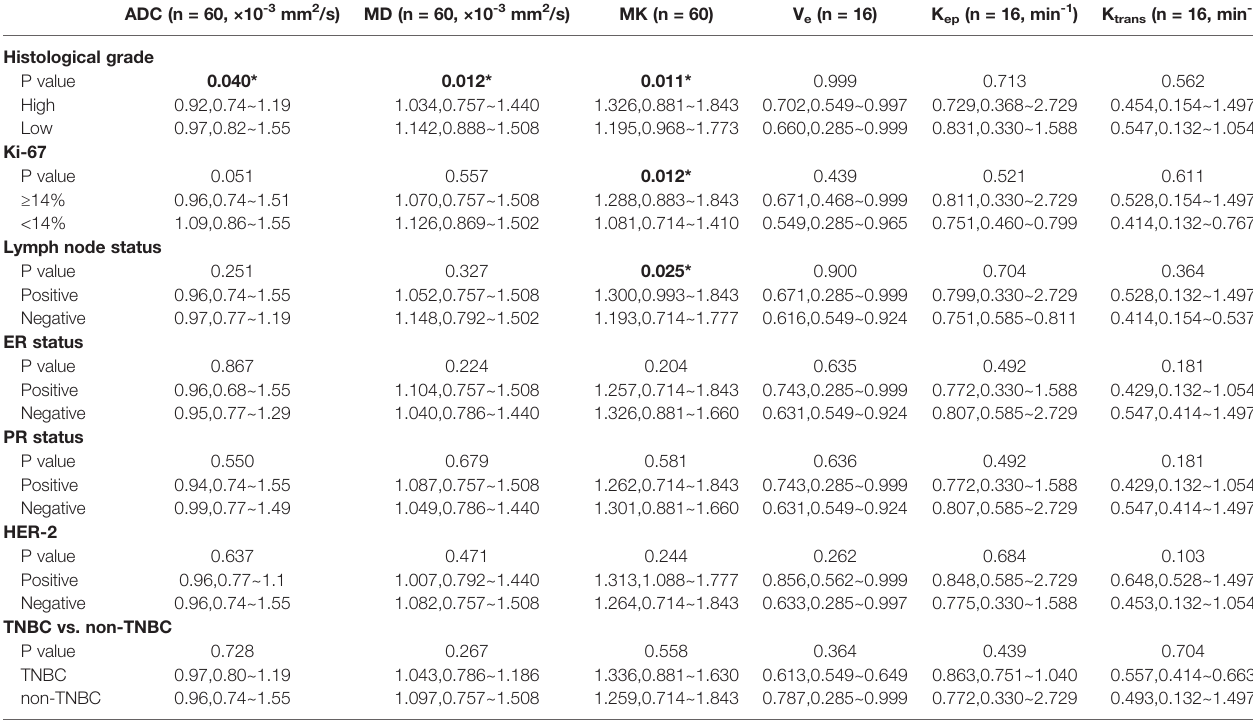
The bold values and the symbol * are all for marking the Signi fi cant statistical